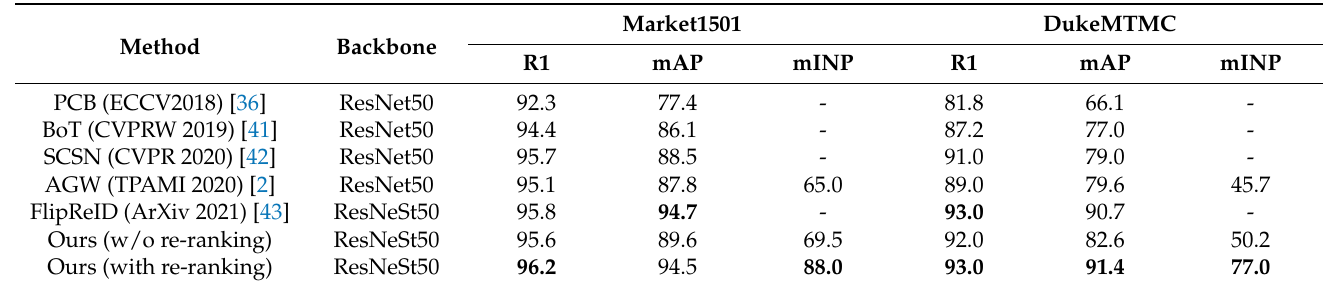
Table 2. Person re-ID performance comparison with state-of-the-art methods on the Market1501 and DukeMTMC datasets (Boldface indicates the best results).